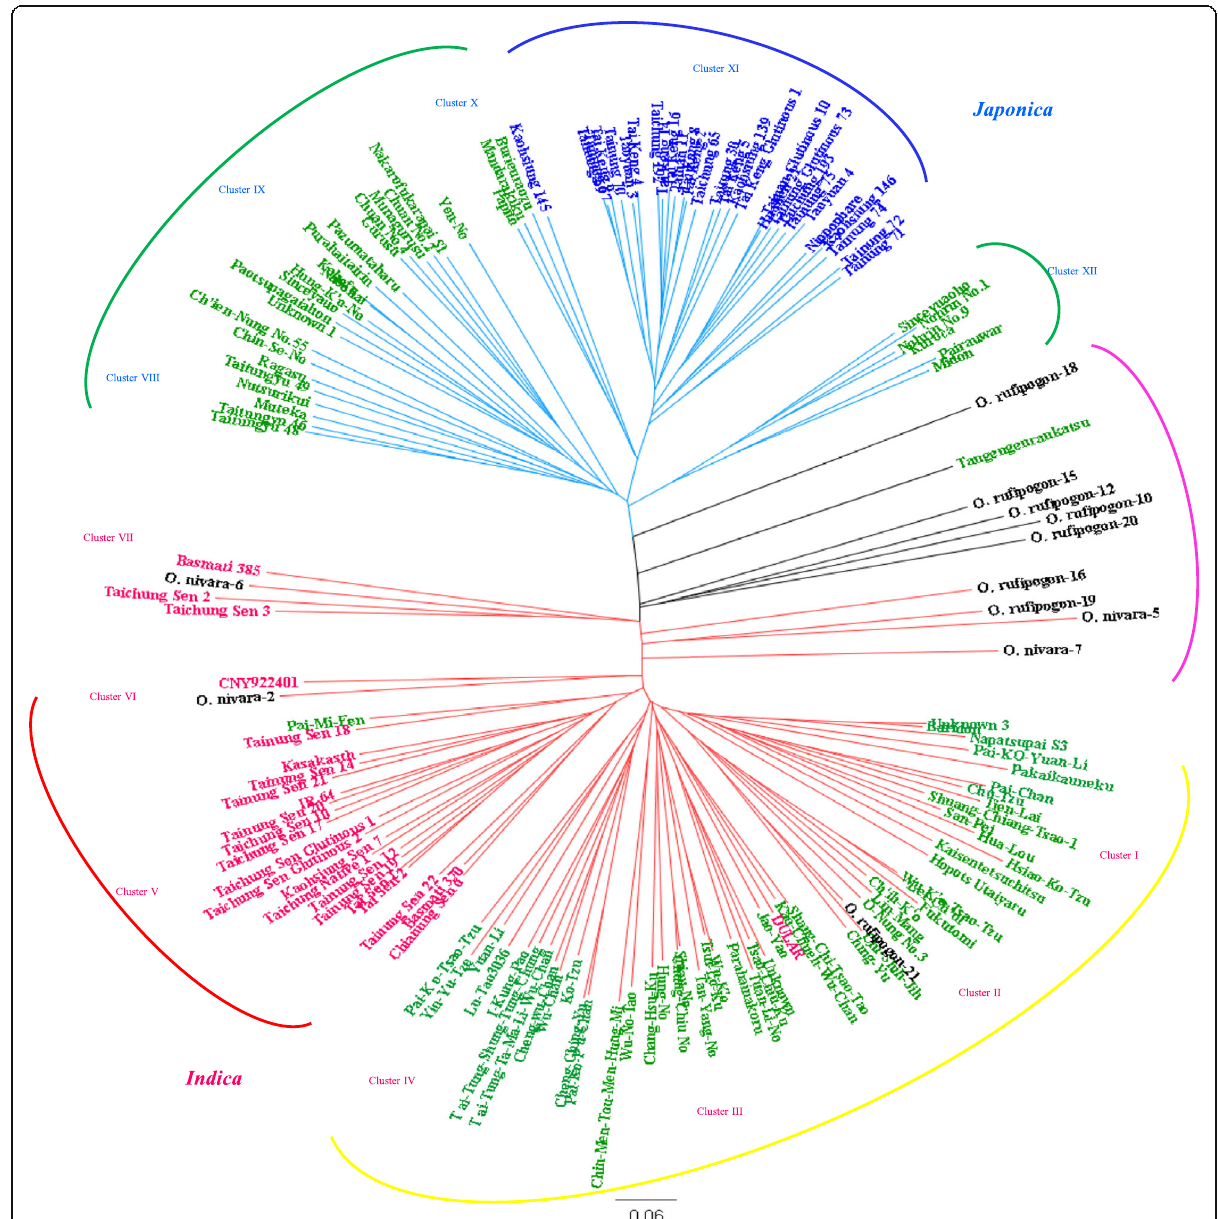
Fig. 2 Unrooted neighbor-joining tree of 148 rice accessions. Genetic distance was calculated according to Nei (1983) with the genotypes of 75 markers and cluster analysis by the neighbor-joining method. Japonica cultivars, indica cultivars, landrace and wild rices are indicated by blue, red, green and black, respectively. Cluster I-VII belong to indica sub-groups and Cluster VIII-XII belong to japonica sub-groups. Bar represents genetic